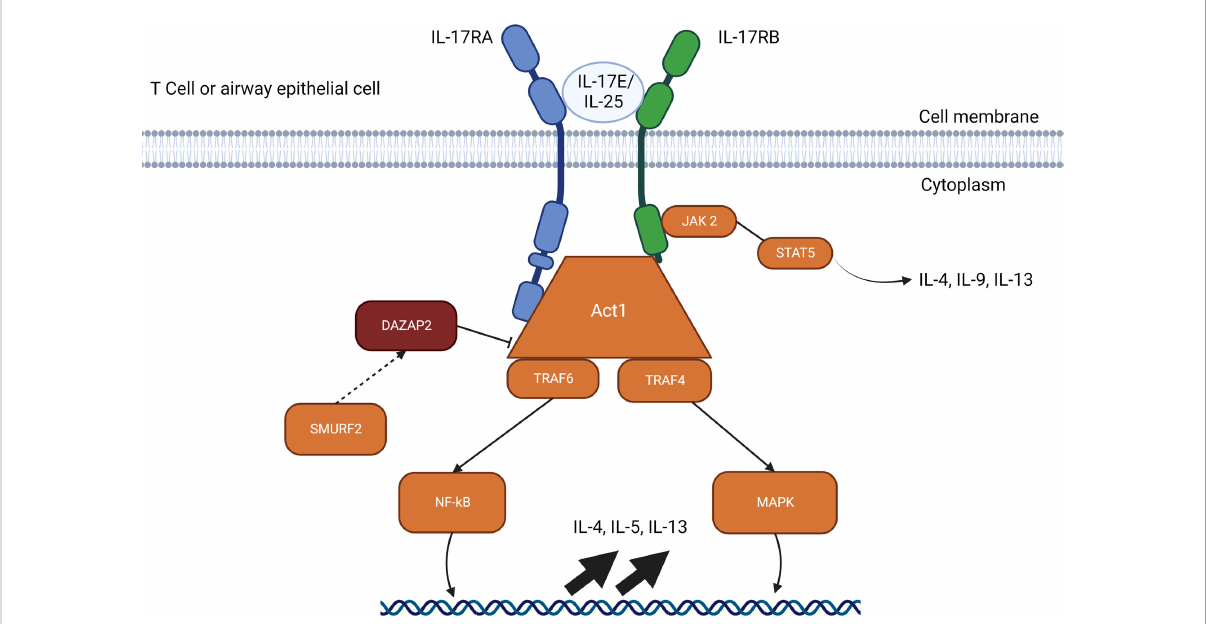
FIGURE 3 IL-25 signalling pathways through Act1. The IL-17E/IL-25 signaling pathway requires a heterodimer of IL-17RA and IL-17RB which allows interactions with Act1. Act1 recruits TRAF4 and TRAF6 which activates gene upregulation through NF-kB. SMURF2 removes the inhibitory effects of DAZAP2 which allows upregulation through MAP kinases and induces JAK2 to signal through STAT5 for IL-4, IL-9 and IL-13. The IL-25 pathways available represent the resolved pathways in T cell and airway epithelial cells, but IL-25 receptors are also found on mast cells, eosinophils, basophils, and other immune